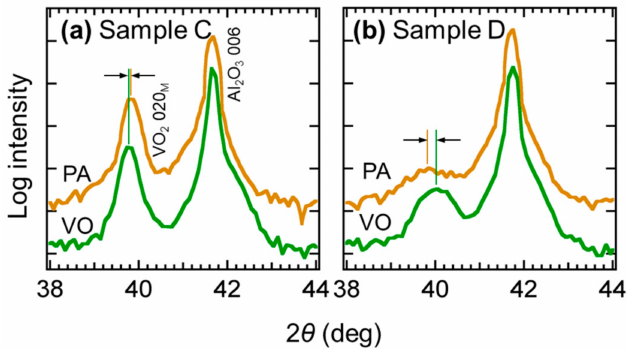
Figure 5. XRD 2 θ − ω scan profiles of Samples C ( a ) and D ( b ) in steps VO and